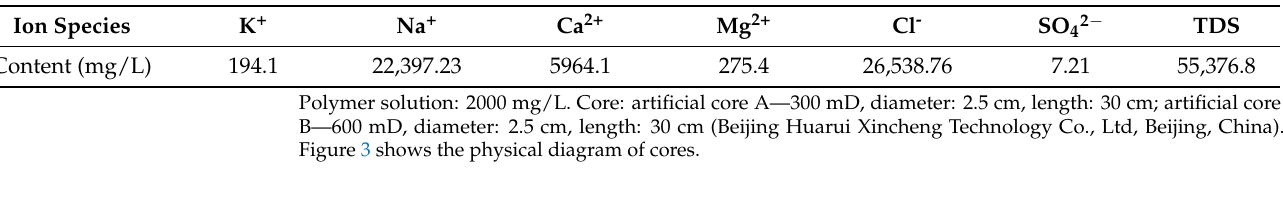
Table 2. Ion composition of water sample.